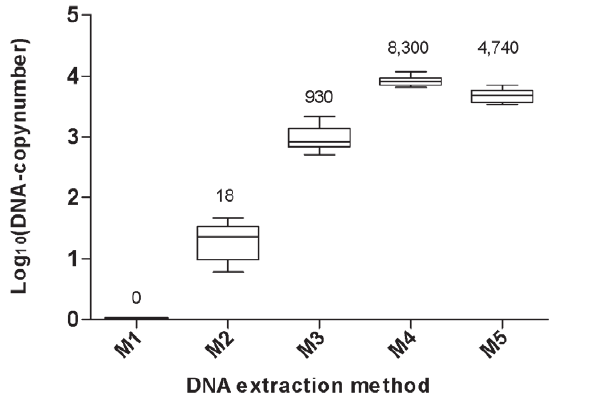
Figure 2. Leptospira sp. DNA recovery and inhibition of PCR. Estimated total copy-number of Leptospira interrogans DNA recovered from a spiked sample of BACTEC TM anaerobic Plus containing approximately 50.000 Leptospira /5 m l by five DNA extraction methods. The mean copy-numbers are given above each column. Error bars indicate the 95% confidence interval. M1: Qiagen, DNeasy H Blood & Tissue Kit; M2: Molzym, MolYsis Plus Kit; M3: Protocol described by Fredricks and Relman; M4: Improved protocol for anaerobic and paediatric blood culture media; M5: Improved protocol adapted for all blood culture media.